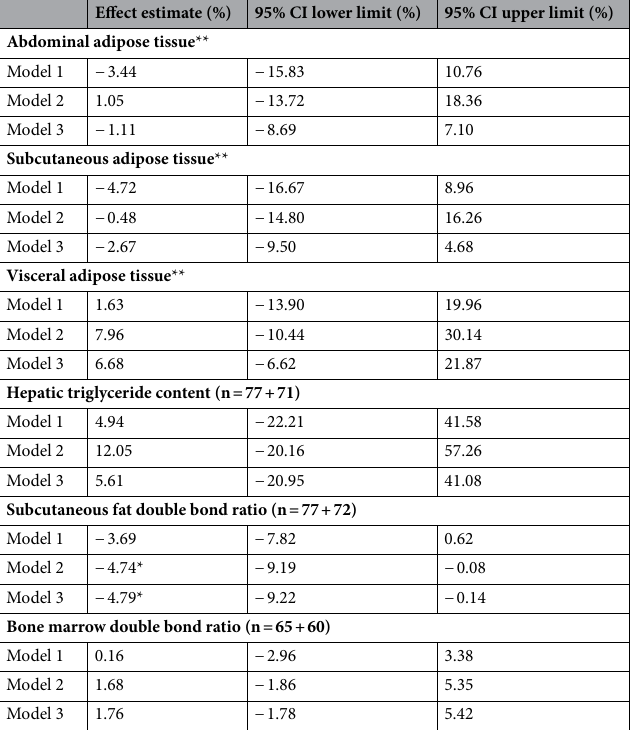
Table 3. Fixed effect estimates indicating mean %-differences between 78 VLBW adults and 72 sibling controls born at term, adjusted for covariates. VLBW: very low birth weight (< 1500 g). Outcomes were log- transformed for analyses and are presented as %-differences using linear mixed models. Model 1 is adjusted for sex and age. Model 2 further adjusts for primiparity, maternal age, maternal BMI, maternal smoking, and gestational hypertension and pre-eclampsia. Model 3 further adjusts for subject’s BMI. *Denotes a statistical significance of p < 0.05. **Data available from 78 VLBW subjects and 71